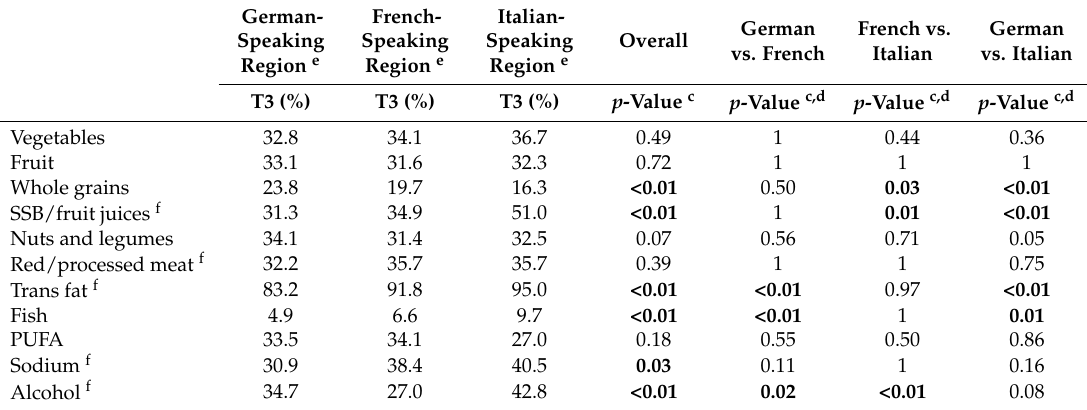
Table 3. Weighted proportions of participants in the highest tertile of each Alternate Healthy Eating Index (AHEI) component and differences between language regions ( n = 2057) a,b .